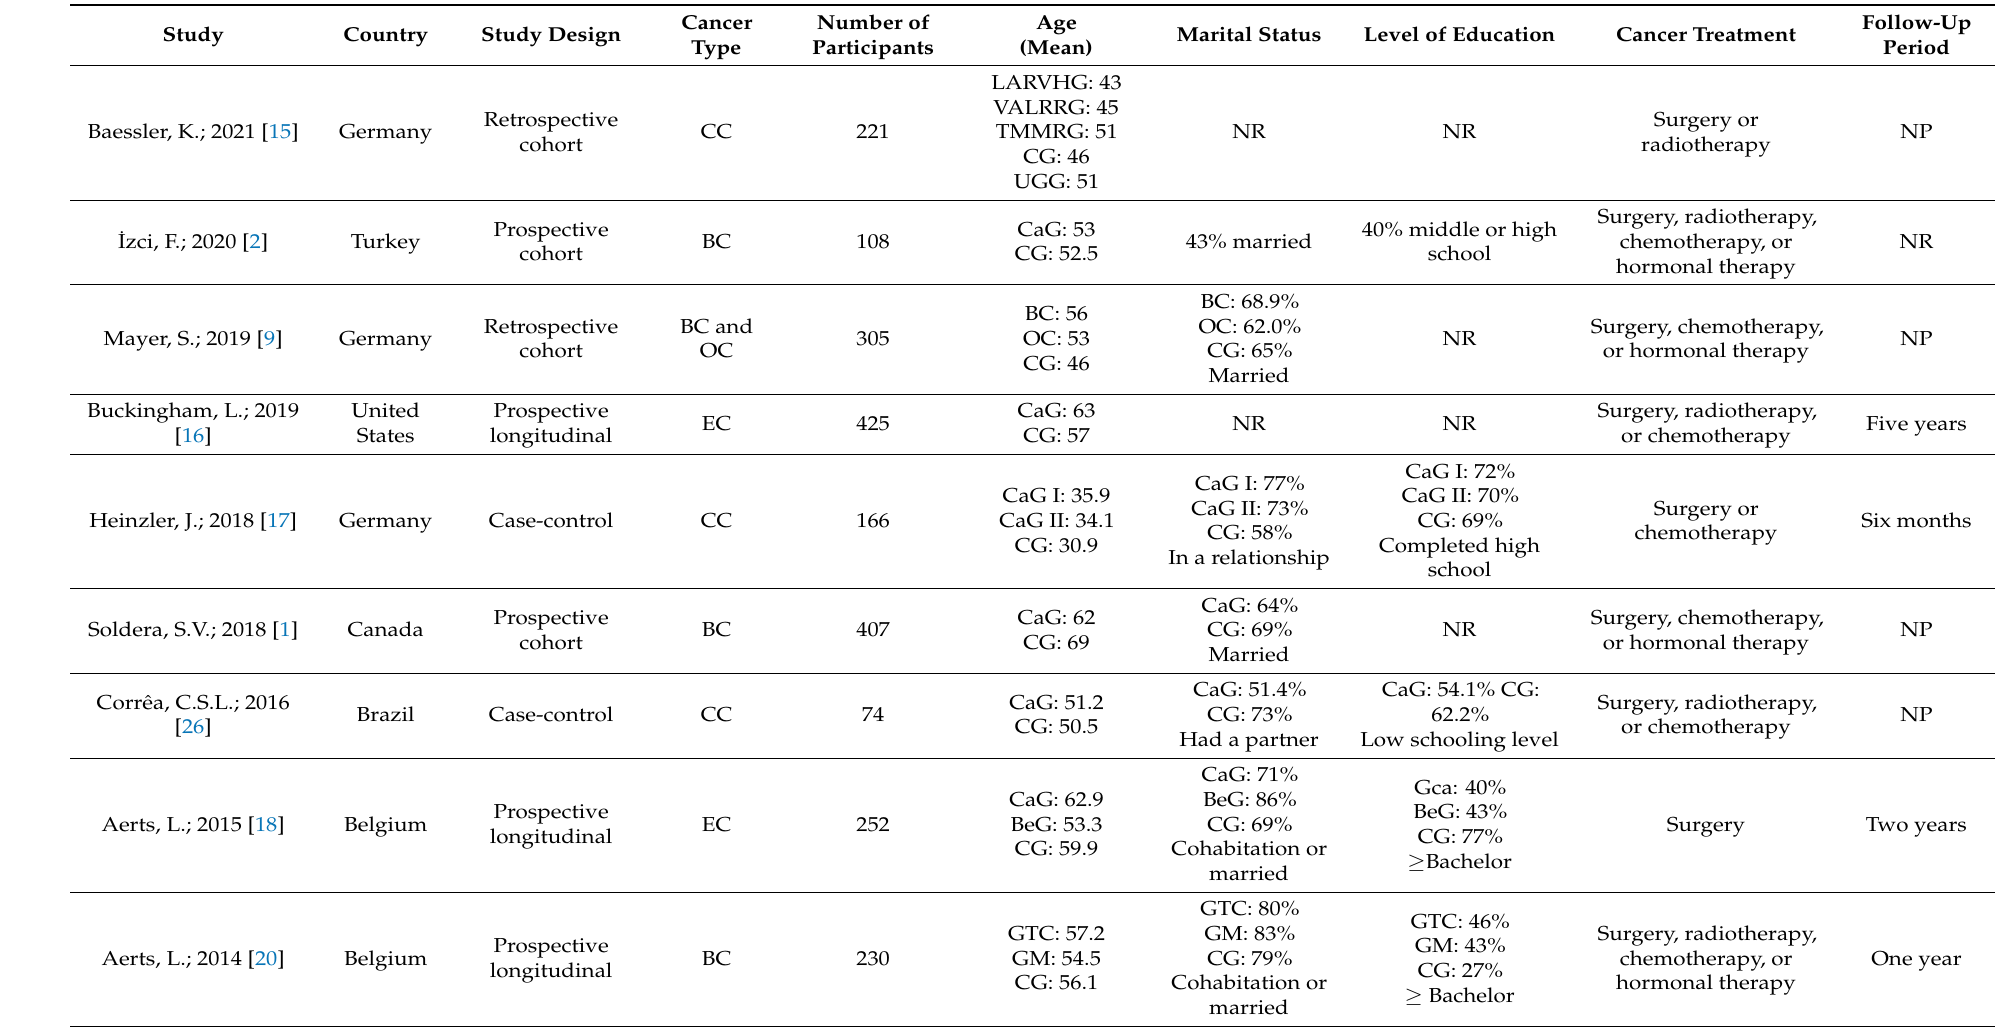
Table 2. Descriptive characteristics of included